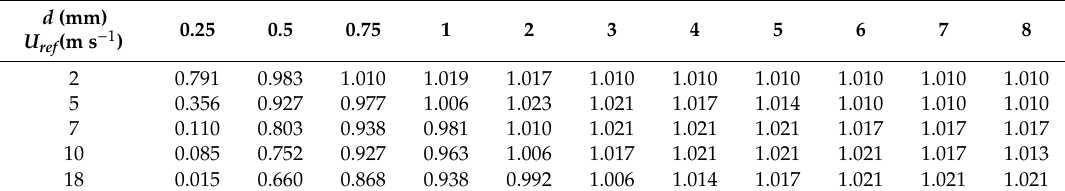
Figure 2. Catch ratios per each drop size, resulting from the LPT model run at different wind speed and based on the airflow fields simulated for the Casella cylindrical rain gauge.